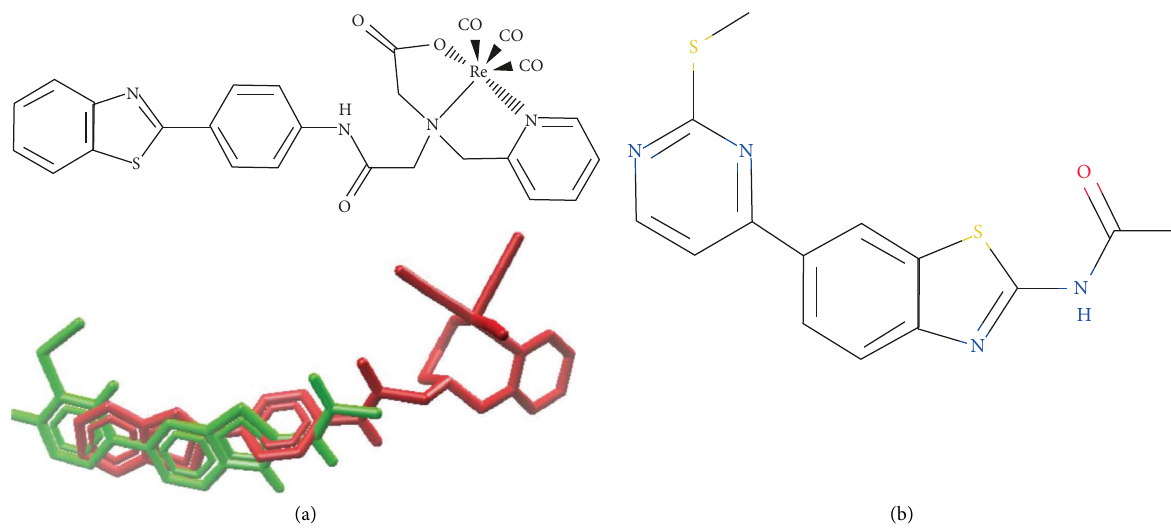
Figure 4: ReABT in red(a) and active ligand in green (b) docked at the PI3K (PDB code 3QJZ) active site.